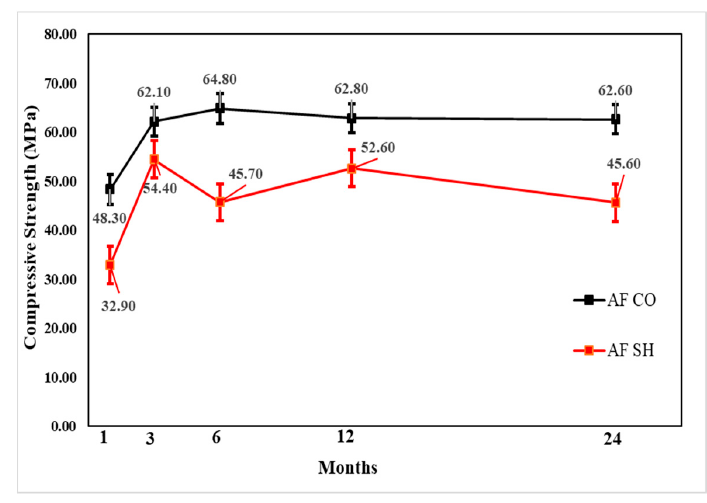
Figure 14. Aluminate (AL) accelerator mix compressive strength by age.